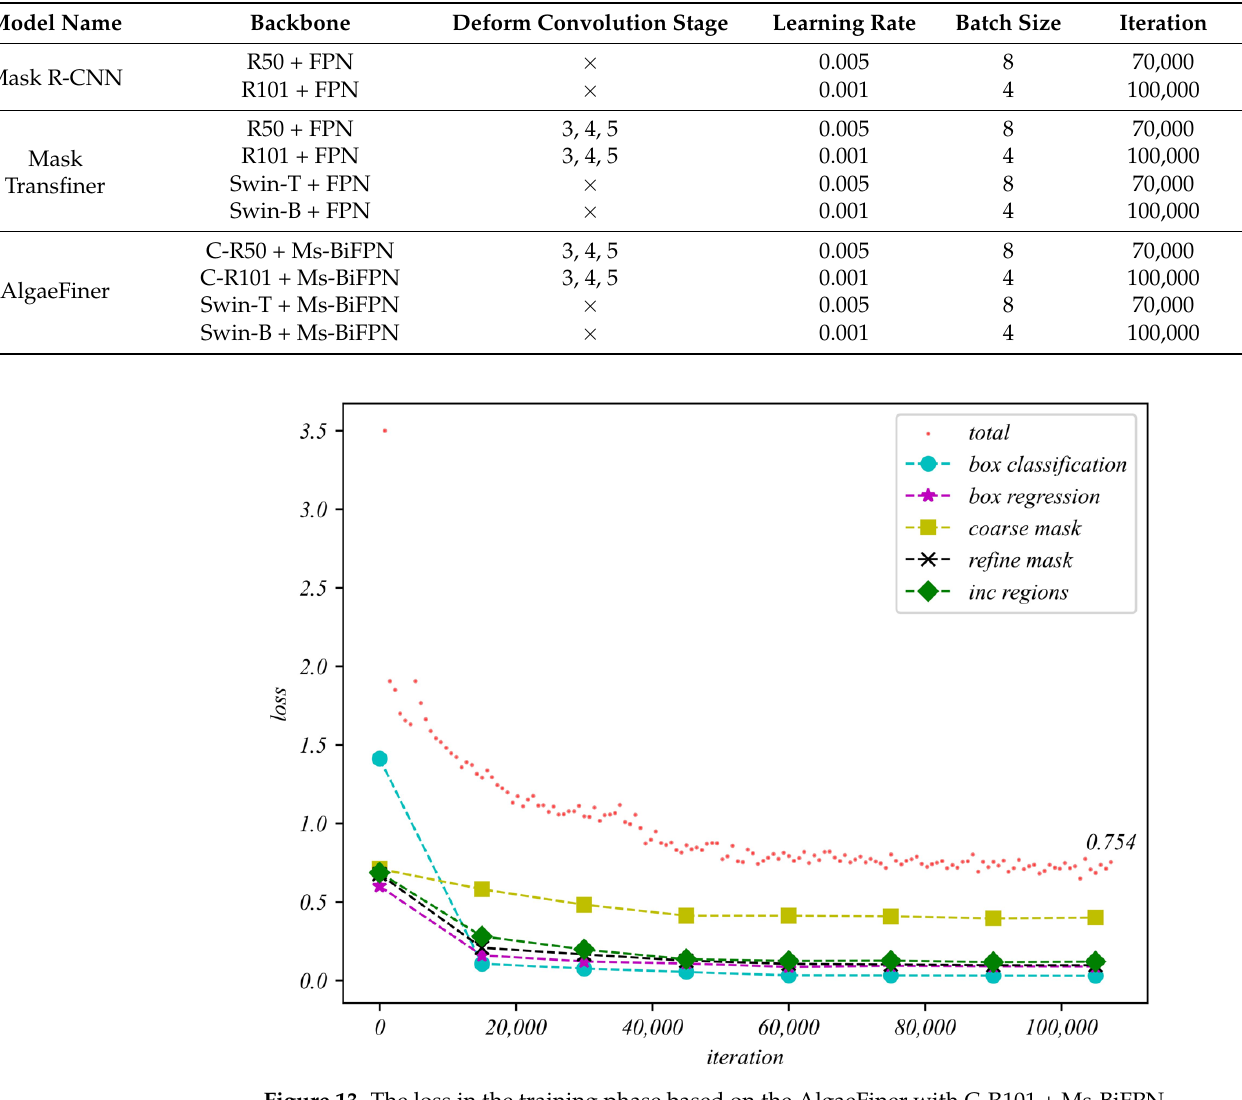
Table 4. Comparison performance of different models on AP.